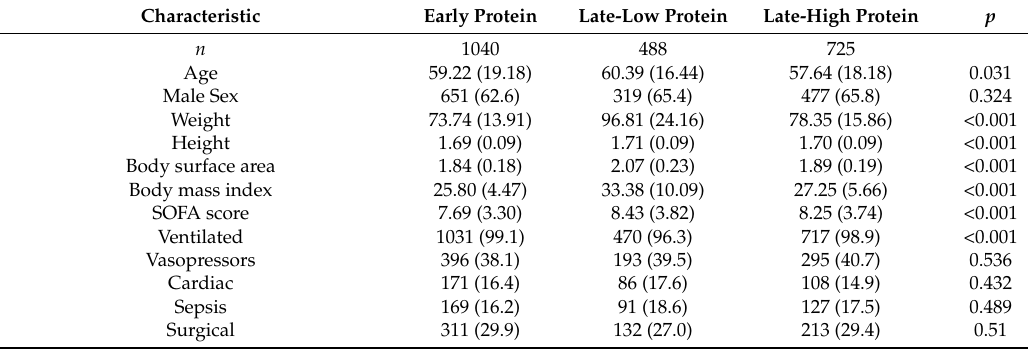
Table 2. Patient Characteristics—Comparison between Early, Late-Low, and Late-High Protein. Characteristic Early